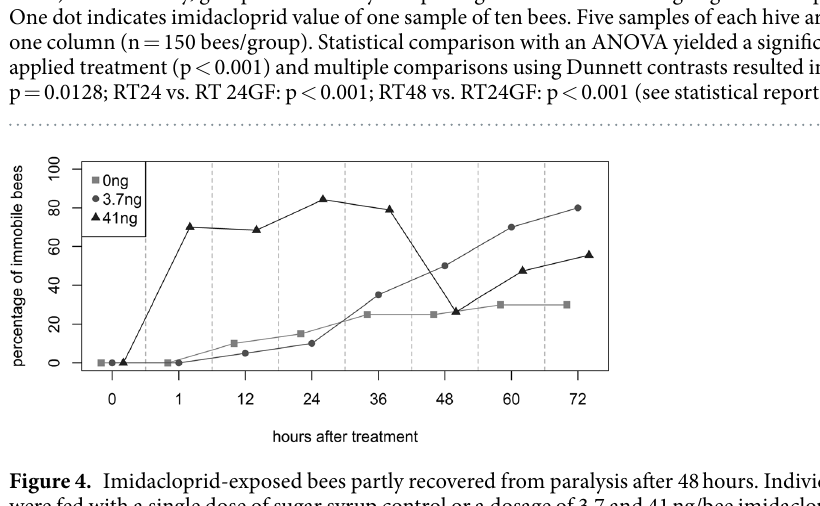
form paralysing toxins. In field realistic conditions however, this question is less relevant since most foragers which come into contact with extremely toxic, paralysing substances may become easy prey and are lost to the colony.